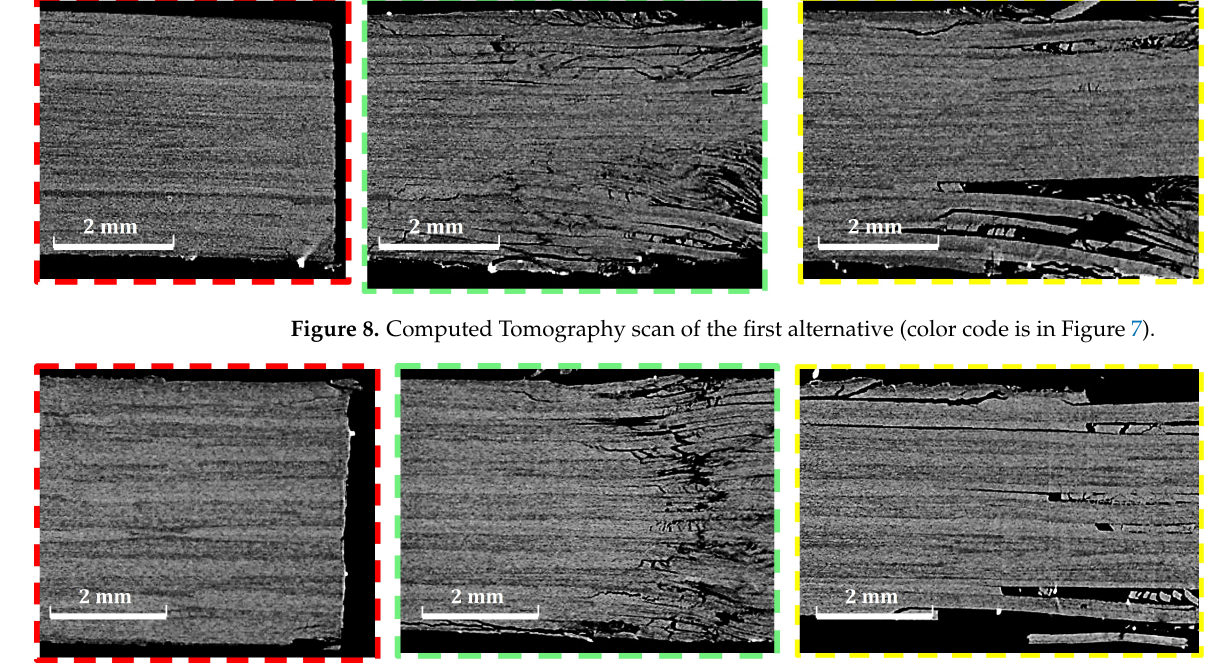
Figure 9. Computed Tomography scan of the second alternative (color code is in Figure